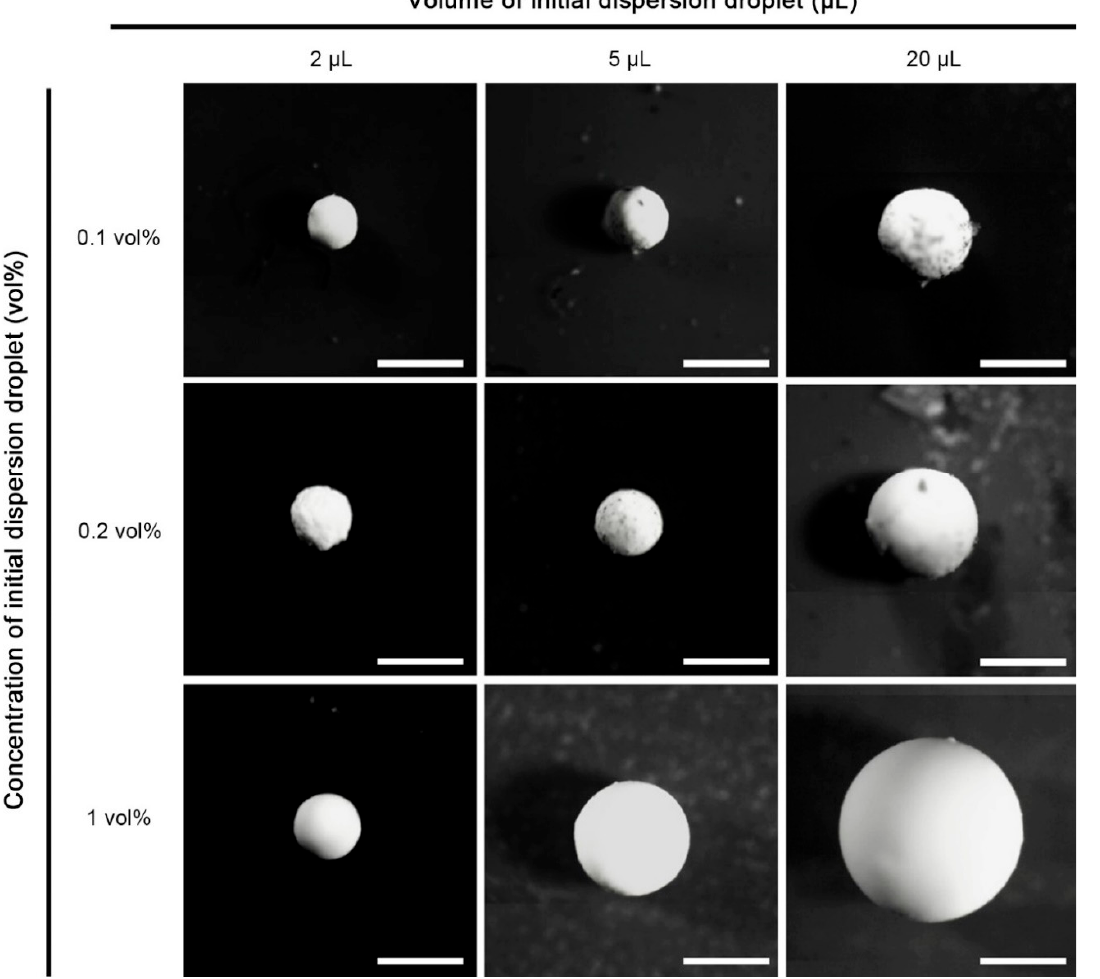
Figure 3. Optical microscopic images of various sizes of TiO 2 supraparticles from different aggregates of NP concentrations (0.1, 0.2, 1 vol %) and volume (2, 5, 20 μ L) of initial dispersion drops. The scale bars are 500 μ m.